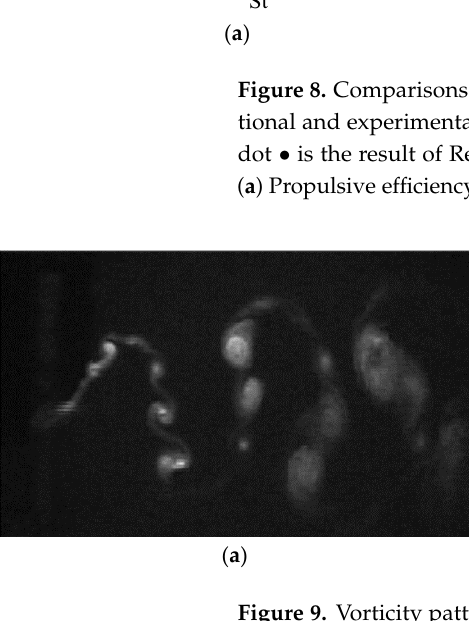
Table 4. The parameters for the simulation.